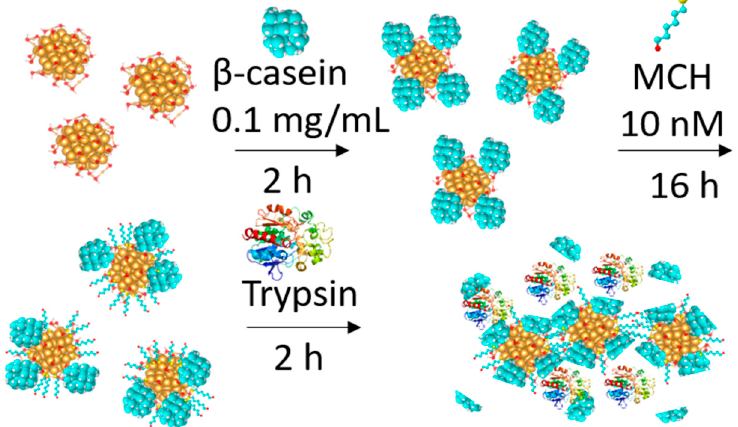
Figure 2. The scheme for modification of gold nanoparticles (AuNPs) by β -casein and by 6-mercapto-1-hexanol (MCH) as well as the cleavage of β -casein by trypsin. Before enzymatic digestion, functionalized AuNPs were stable due to steric stabilization. After the AuNPs were subjected to protease cleavage, the casein was removed from the surface of AuNPs/MCH/ β -casein. This caused the destabilization of the NPs, followed by their aggregation.